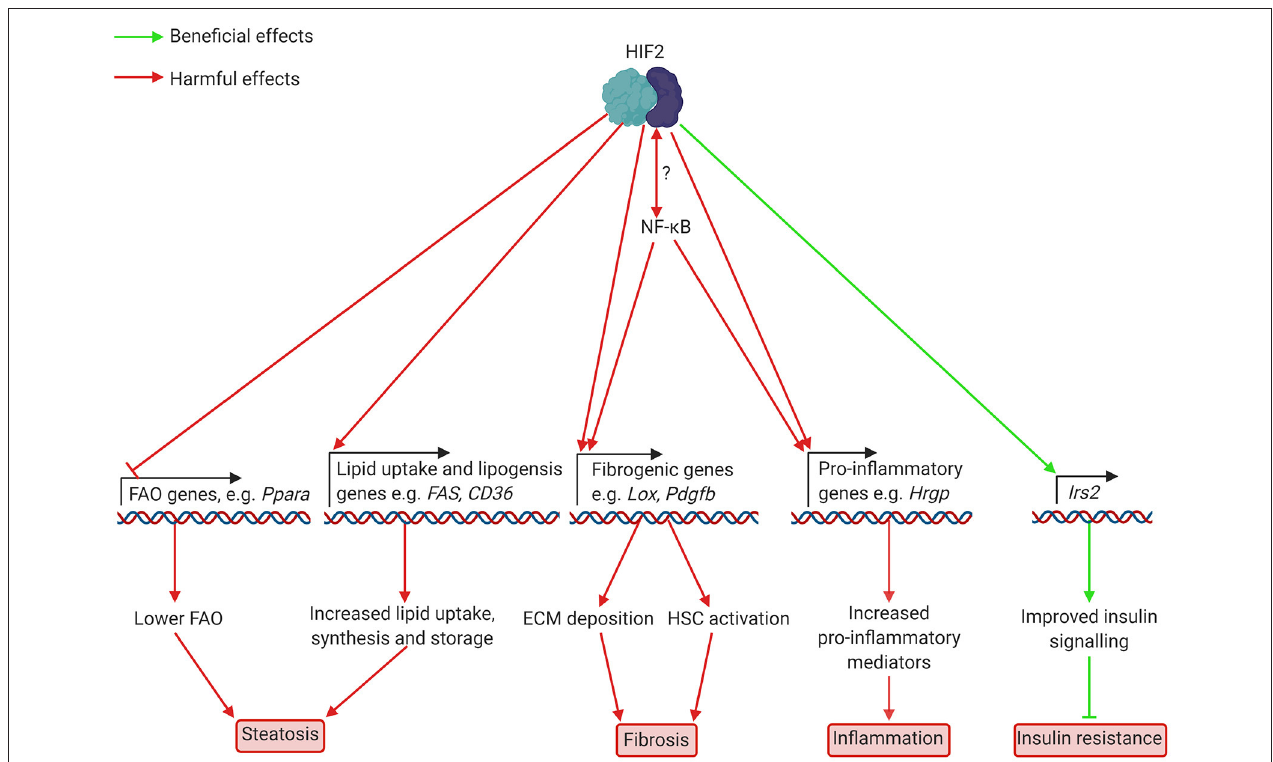
FIGURE 2 | Putatively beneficial and harmful effects of HIF2 activation in hepatocytes in NAFLD and NASH. HIF2 activation leads to lower expression of FAO genes, including Ppara, which encodes PPAR α . This decreases FAO, leading to increased lipid accumulation. Higher levels of fibrogenic mediators such as LOX and potentially PAI-1, which are involved in ECM deposition, also occur as a result of HIF2 activation. Increased production of HSC activators may also occur but this has not yet been demonstrated in NAFLD/NASH. HIF2 mediated upregulation of the pro-inflammatory cytokine HRGP worsens inflammation. Interplay between HIF2 and NF- κ B appears likely, but details of this interaction are unknown. Finally, increased transcription of the insulin signalling component Irs2 appears to improve insulin signalling to prevent insulin resistance. ECM, extracellular matrix; FAO, fatty acid oxidation; HIF, hypoxia-inducible factor; Hrgp, histidine rich glycoprotein; HSC, hepatic stellate cell; Irs2, insulin receptor substrate 2; Lox, lysyl oxidase; NF- κ B, nuclear factor kappa-light-chain-enhancer of activated B cells; Ppara, peroxisome proliferator-activated receptor α ; Fas, fatty acid synthase; CD36, cluster of differentiation 36; Pdgfb, platelet derived growth factor